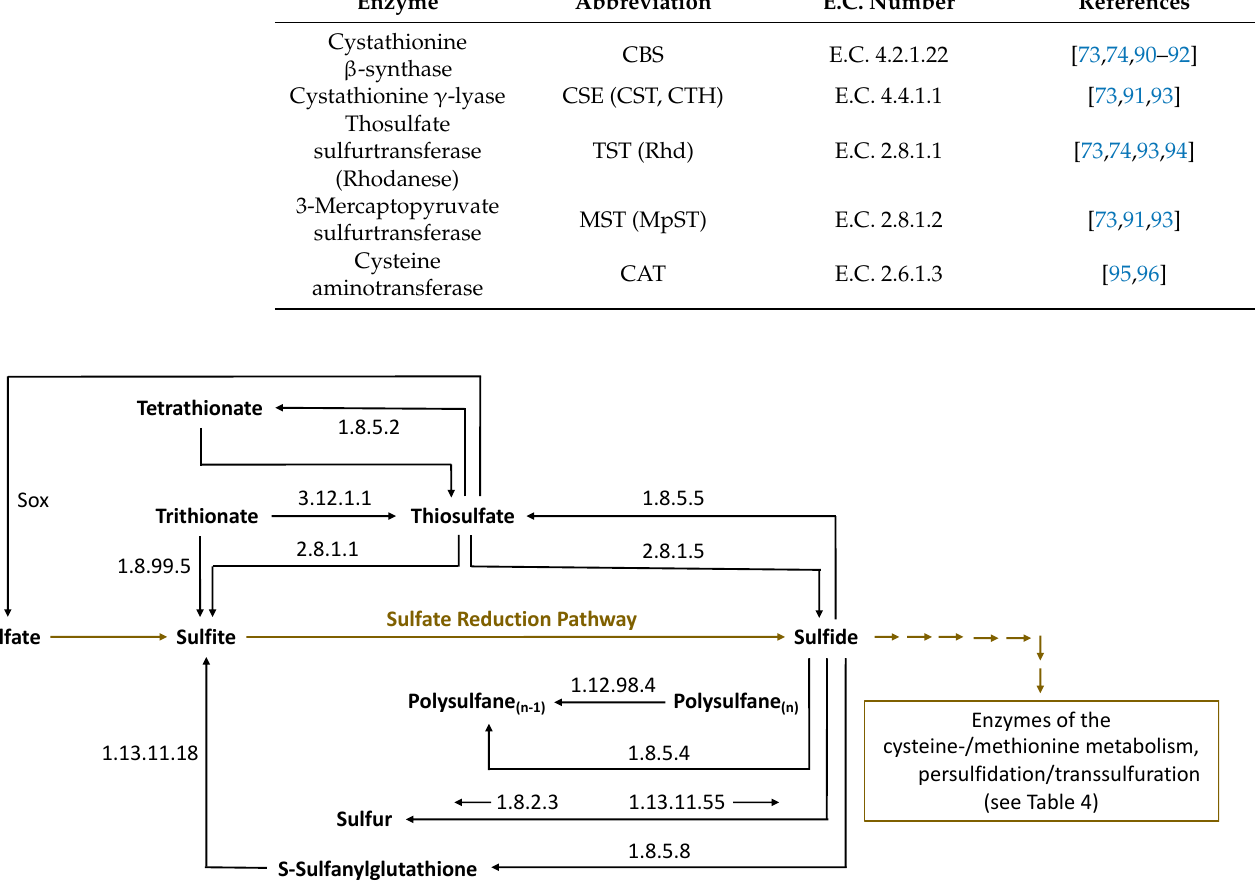
Figure 6. Sulfane sulfur compounds in the sulfur metabolism of Saccharomyces cerevisiae (including the enzymes involved), based on BRENDA [88] and KEGG [89] (Sox — sulfur oxidation enzyme sys- tem). Table 3. Enzymes involved in cysteine/methionine metabolism, persulfidation/transsulfuration.